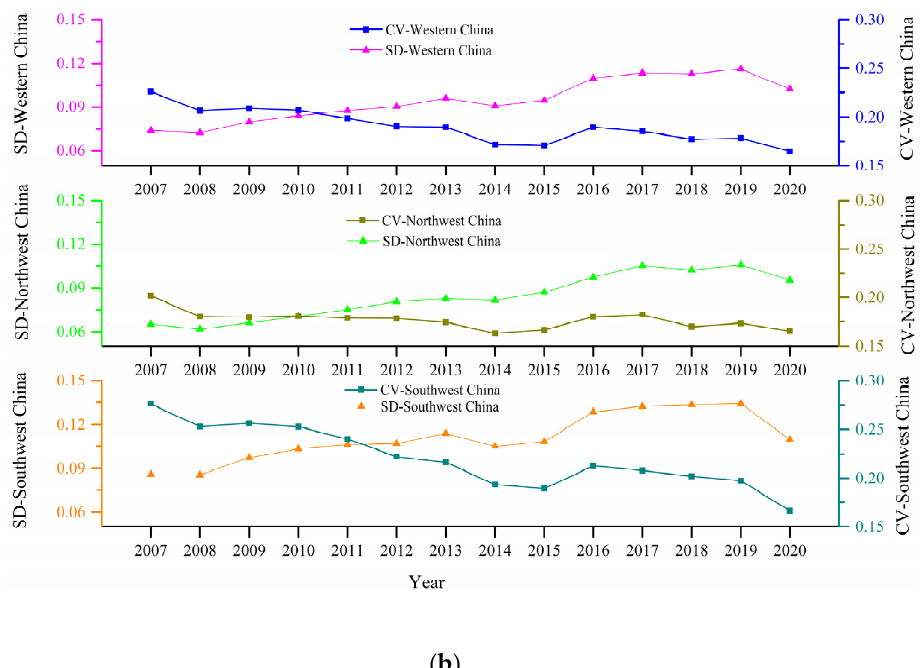
Figure 5. Line charts of Thiel index, standard deviation, and coefficient of variation in five western and northwestern provinces (regions) and five southwestern provinces (regions) in China. Northwest China includes Shaanxi Province, Gansu Province, Qinghai Province, Ningxia Hui Autonomous Region, and Xinjiang Uygur Autonomous Region. Southwest China includes Chongqing, Sichuan Province, Guizhou Province, Yunnan Province, and Tibet Autonomous Region. The graphs ( a ) show Thiel index for western, northwestern, and southwestern regions. The graphs ( b ) show standard deviation and coefficient of variation for the three regions.